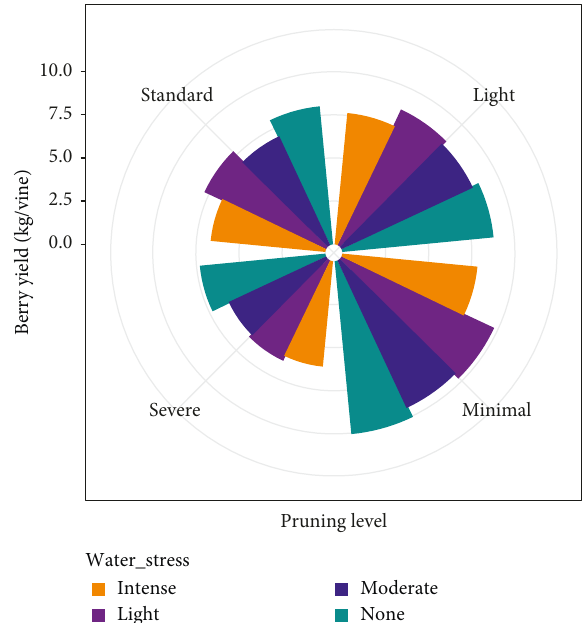
Figure 6: Combination effect of pruning level and water stress in grapevine yield per vine.